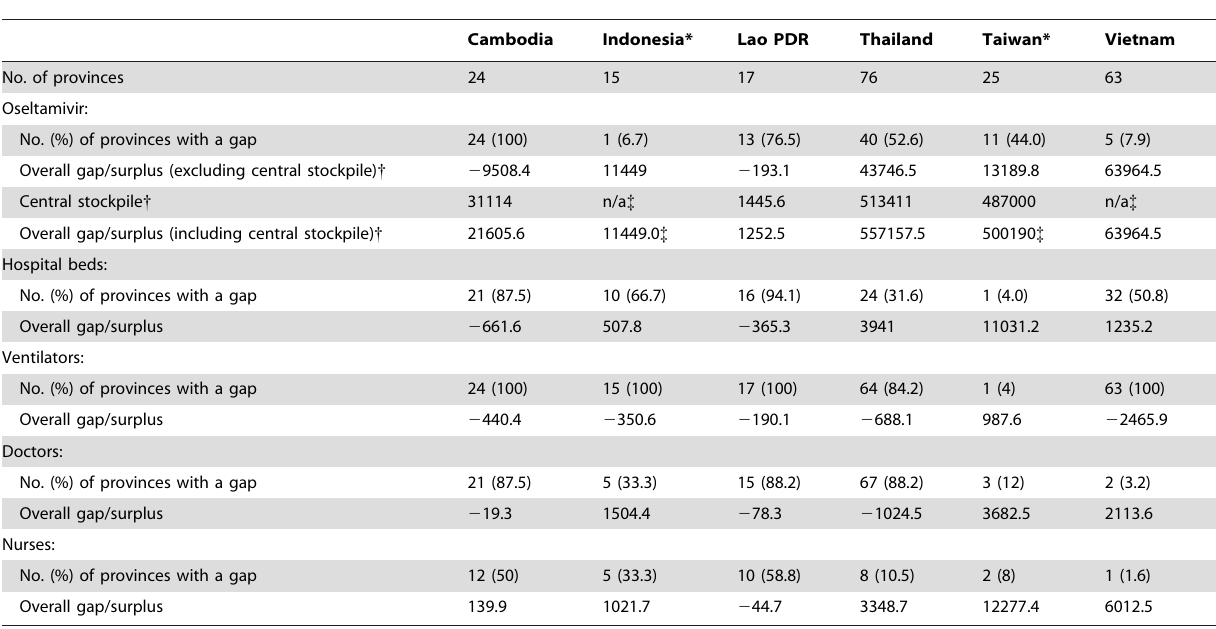
Table 1. Summary of estimated resource gaps for a modeled pandemic influenza